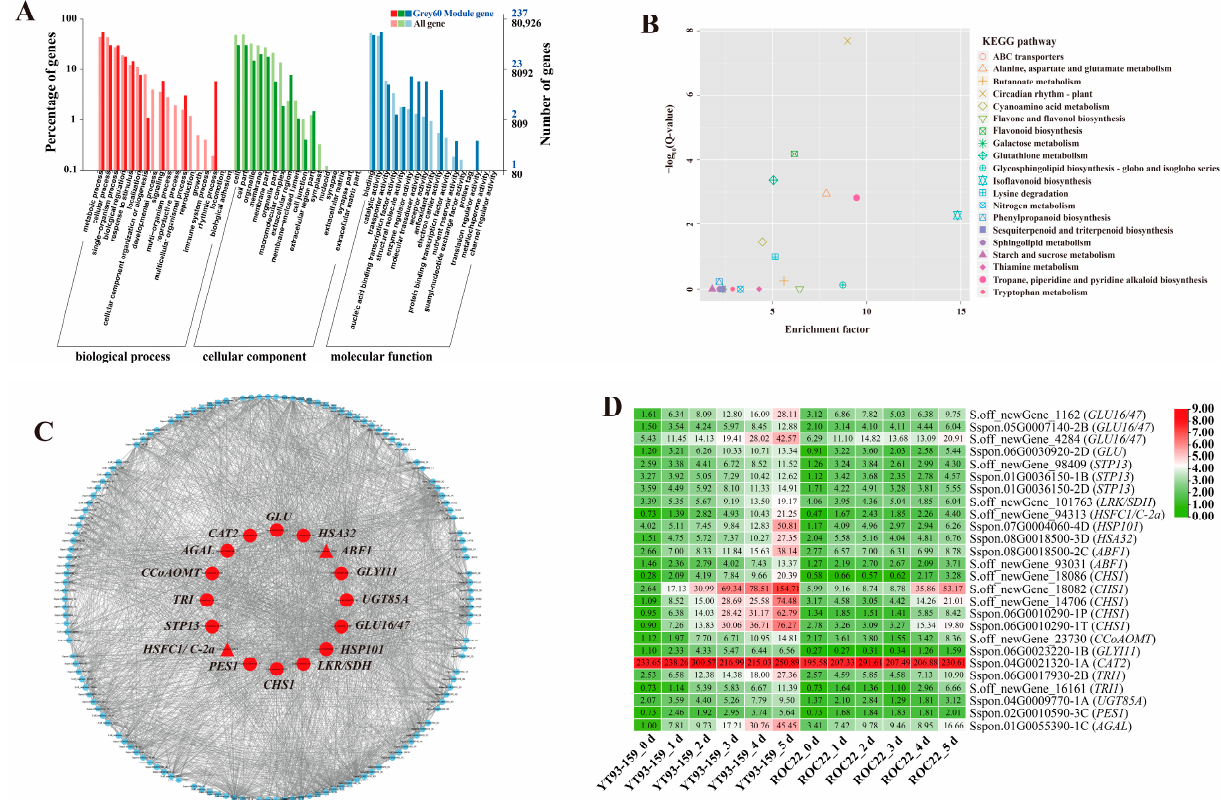
Figure 8. GO enrichment, KEGG enrichment, gene co-expression network and expression patterns of hub genes in the Grey60 module. ( A ) GO functional enrichment analysis. ( B ) KEGG functional enrichment analysis. ( C ) A gene co-expression network and hub genes. The red represents hub gene, the triangle represents transcription factor, and genes with a higher connectivity in the corresponding network are shown in larger circles. ( D ) Expression patterns of hub genes by transcription measured. YT93-159_0 d to _5 d and ROC22_0 d to _5 d represent YT93-159 and ROC22 at 0 d to 5 d post- S. scitamineum inoculation, respectively.